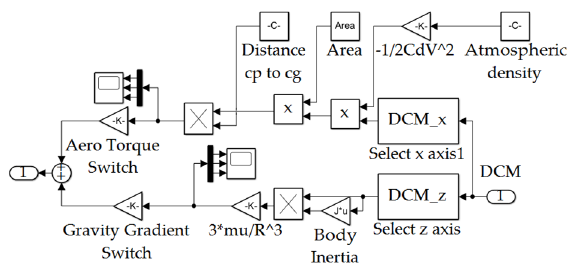
Figure A8. Dynamics Calc subsystem depicted in Figure A1.